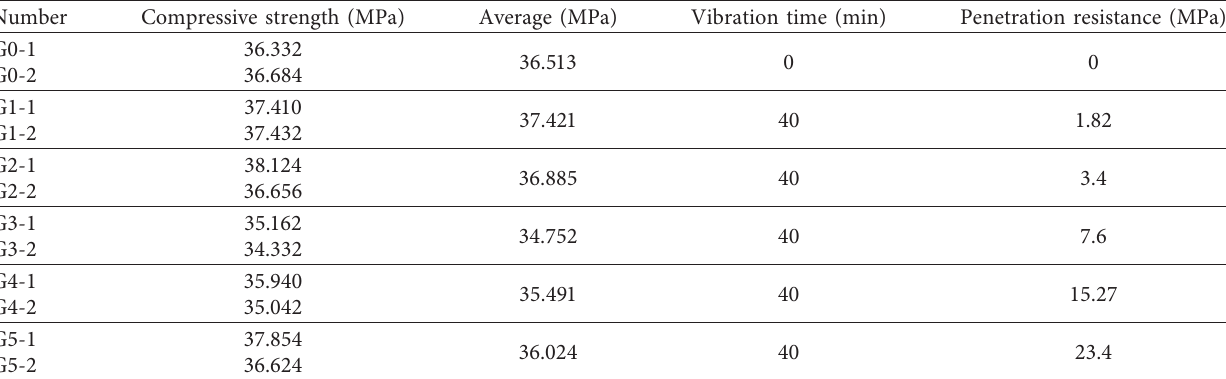
Table 6: Compressive data of basalt fiber concrete.